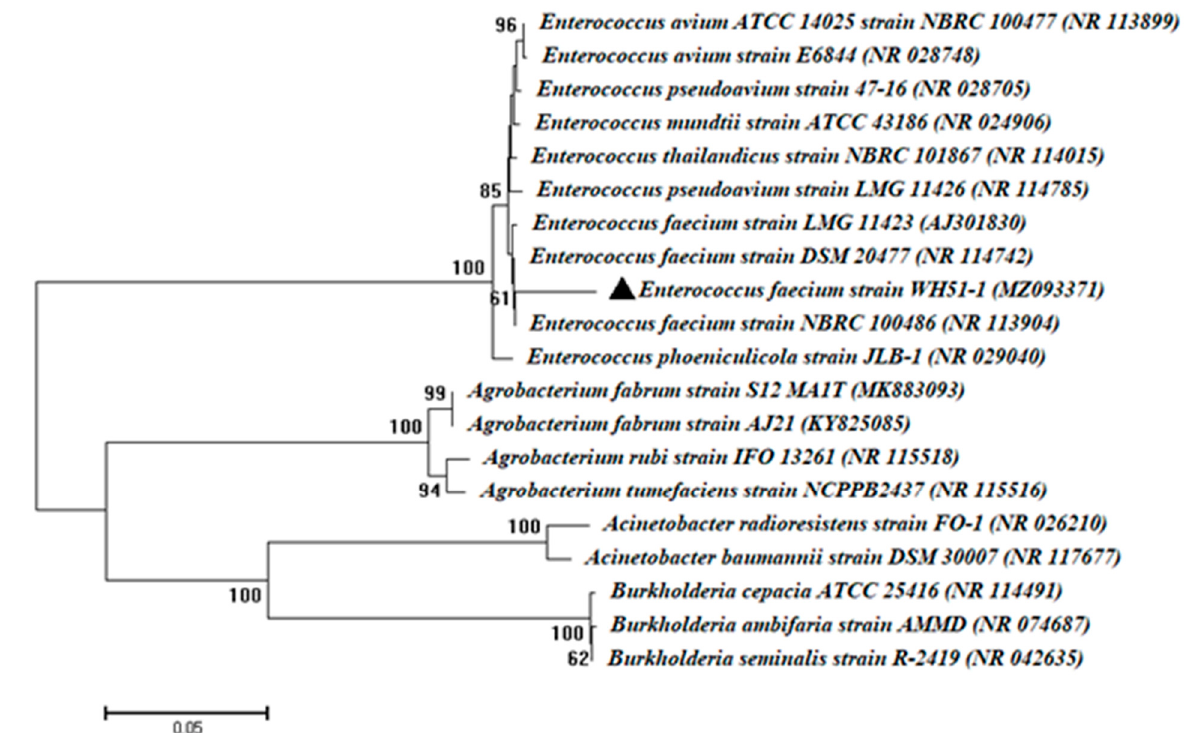
Figure 2. Phylogenetic analysis of 16S rRNA sequences of the bacterial isolate with the sequences from NCBI. The symbol ▲ refers to 16S rRNA gene fragments retrieved from this study. The analysis was conducted with MEGA 6 using the neighbor-joining method.